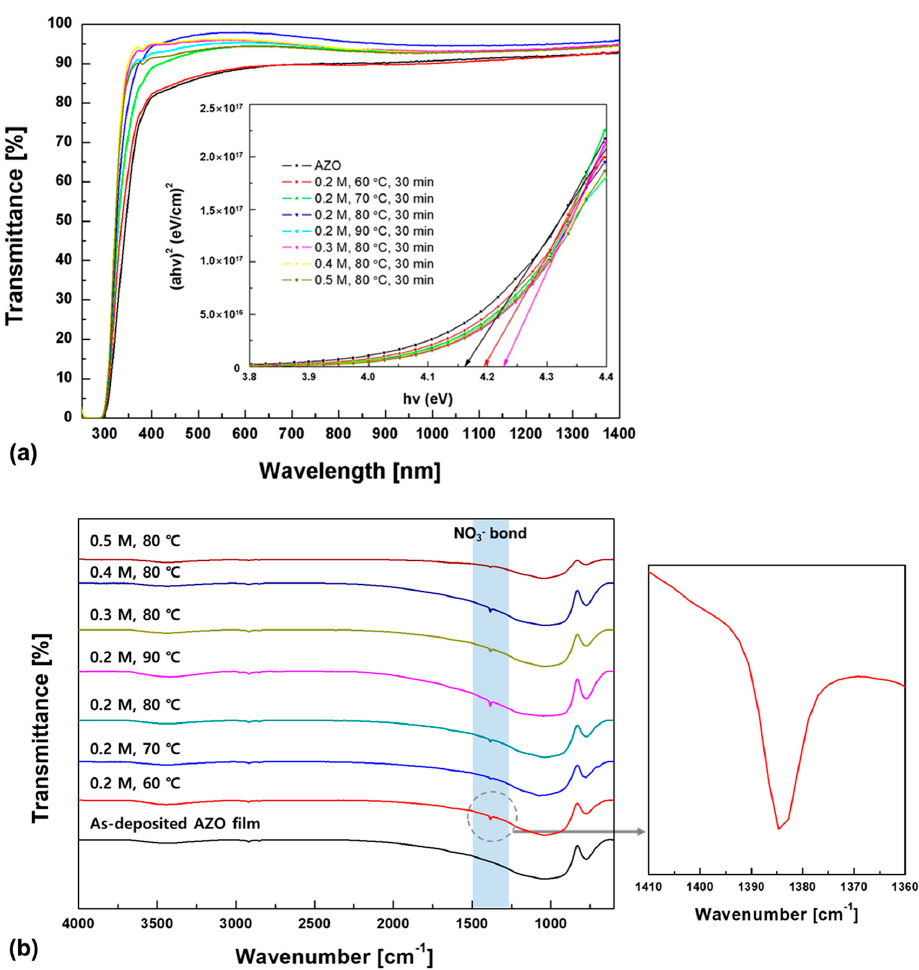
Figure 5. ( a ) Transmittance of all the samples, inset is optical bandgap energies; ( b ) Fourier-transform infrared spectroscopy (FT-IR) spectra of all the samples.